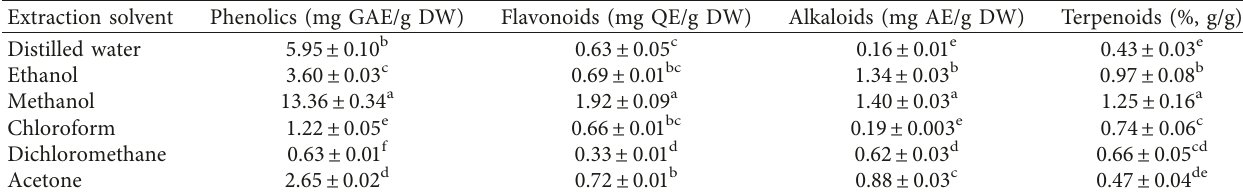
Table 1: Effect of different solvents on phenolic, flavonoid, and alkaloid content of S. buxifolia branches. Extraction solvent